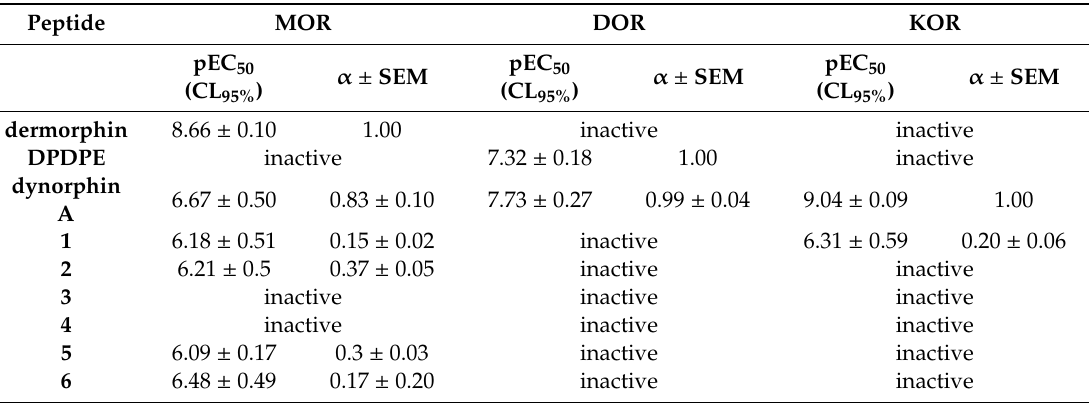
Table 2. Agonist potencies (pEC 50 ) and efficacies ( α ) of analogs 1 – 6 determined on the µ-opioid receptor (MOR), δ -opioid receptor (DOR) and κ -opioid receptor (KOR) coupled with calcium signaling via chimeric G proteins.